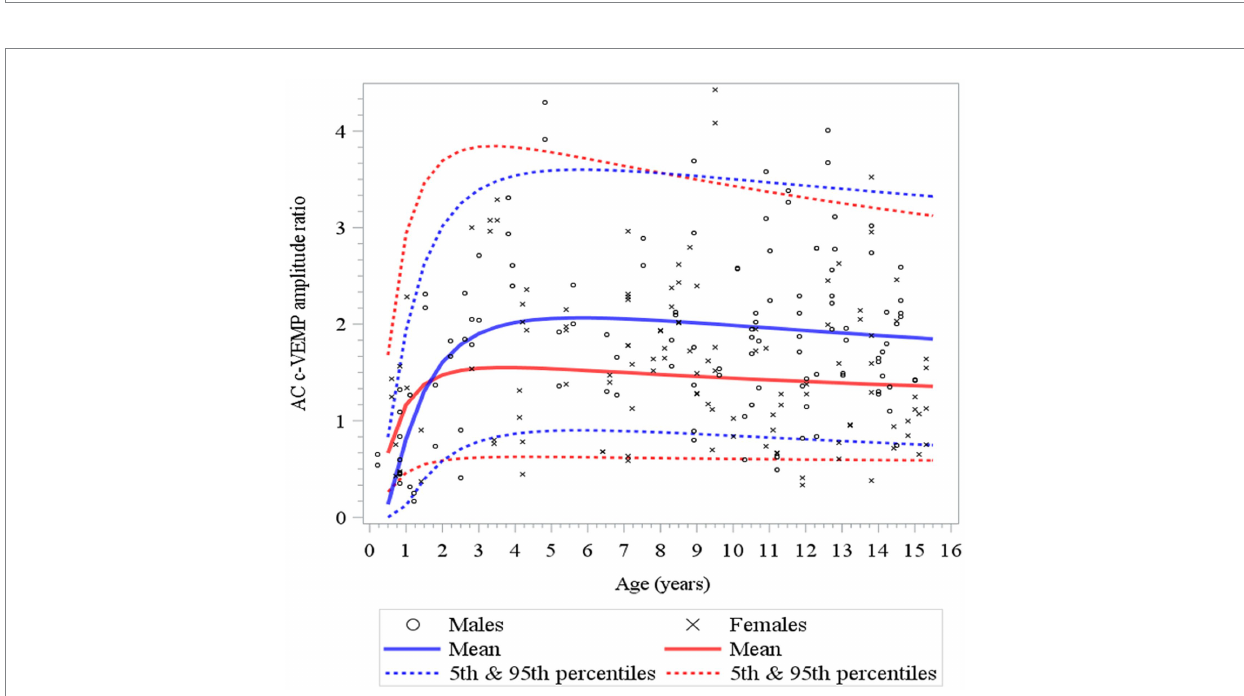
FIGURE 7 Changes in c-VEMP amplitude ratio for AC (air conduction) as a function of age and gender for children (6 months to 15 years of age) (26). After an initial rapid increase that lasts 4 to 5 years, but earlier in females (3 to 4 years) than in males (6 years) as shown also in Table 3. Note that although the mean of the amplitude ratio is higher for males than females, but this difference falls within the 95% confidence